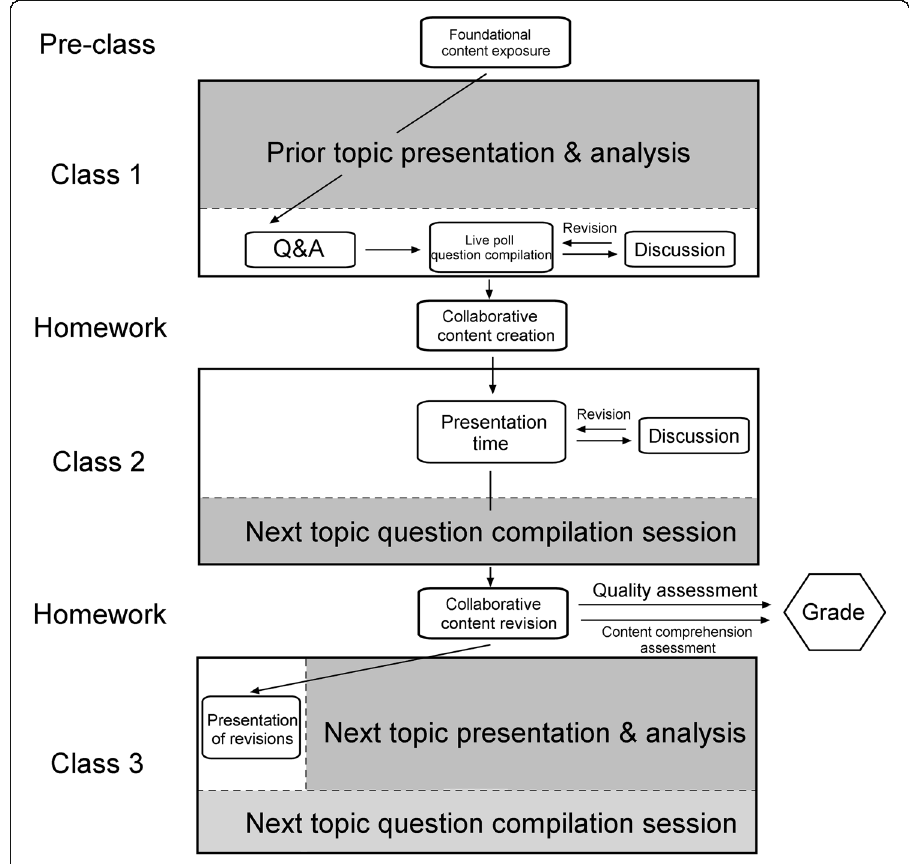
Fig. 3 The co-creational model of instruction. The schematic presentation of the co-creational variant of the flipped classroom